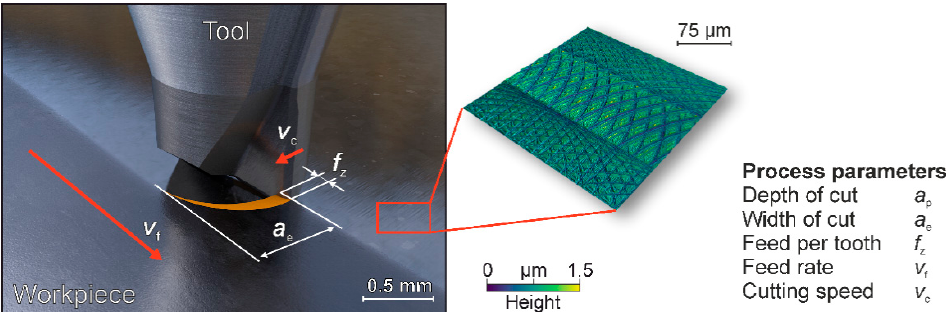
Figure 1. Schematic visualization of a face micromilling process.